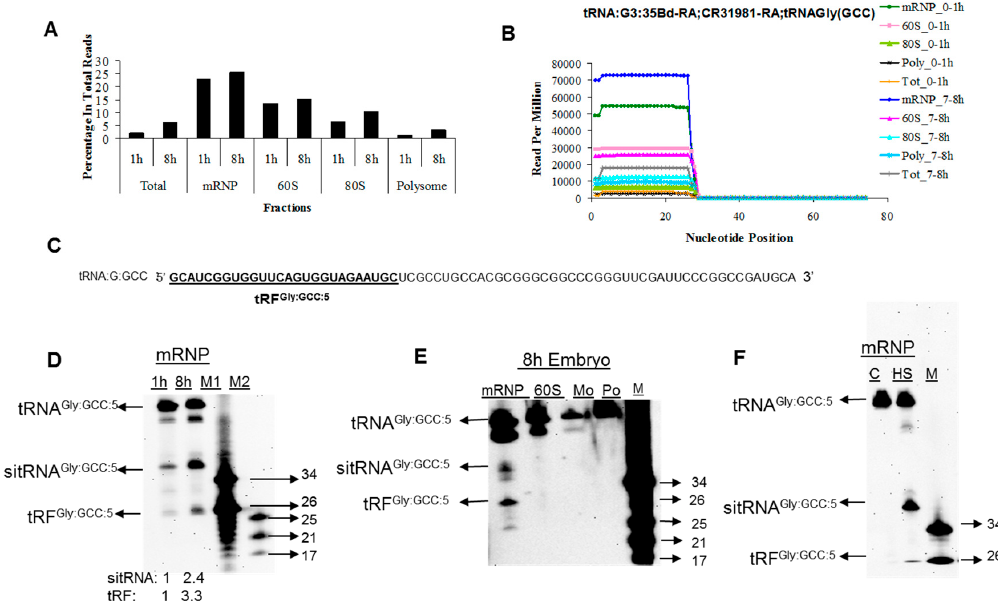
Figure 2. tRNA-derived fragments are associated with mRNP and 60S fractions. ( A ) Cloning frequency of tRNA-derived fragments in unfractionated (Total) and fractionated (mRNP, 60S, 80S and Polysome) samples. ( B ) Cloning frequency of each nucleotide derived from tRNA Gly:GCC . ( C )